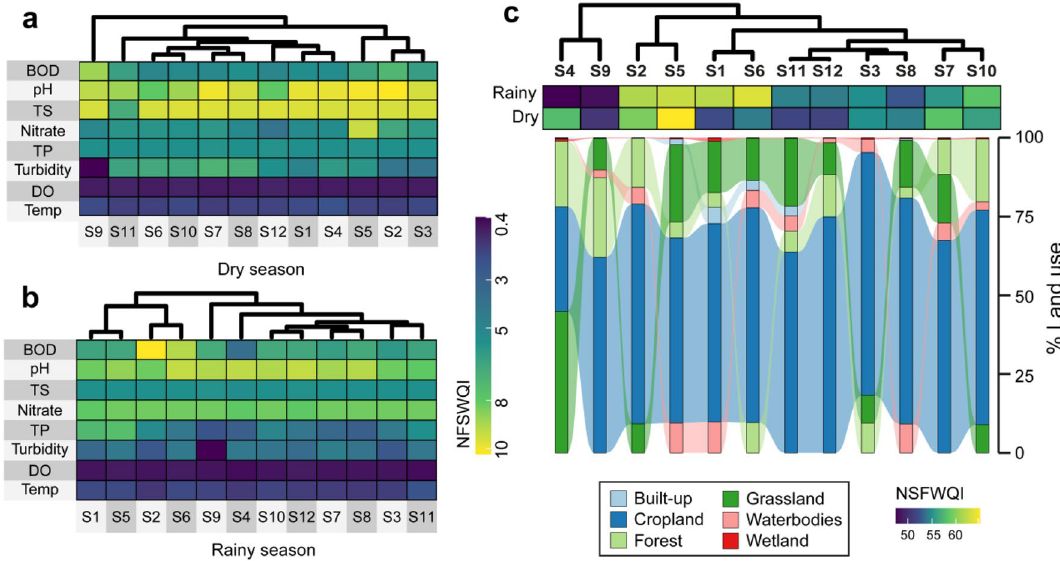
Figure 6. Heatmaps and hierarchical cluster analyses of the water quality parameters in seasons ( a , b ) and sample clustering based on NSF-WQI and the percentage of land use types at each sampling site ( c ). Source: authors´ self-implementation with R software version 4.0.0 (https:// www.r- proje ct.